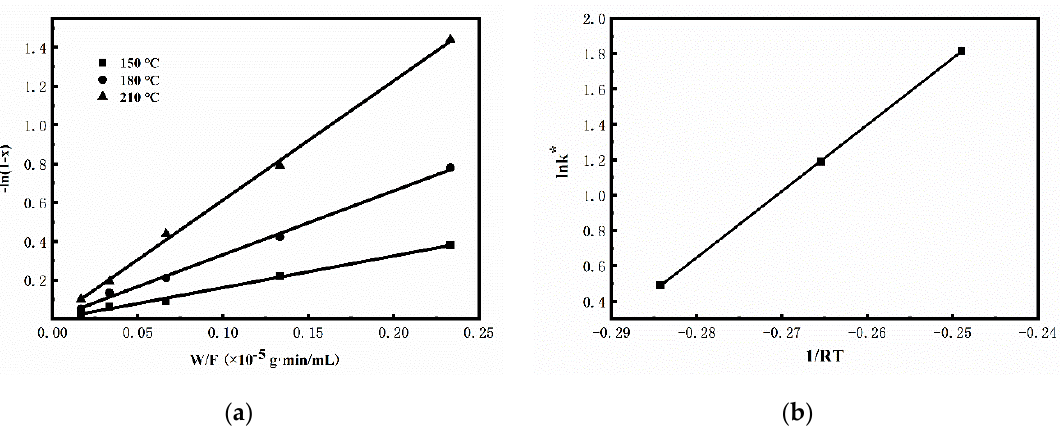
Figure 3. ( a ) First ‐ order reaction of NO result from which to determine the apparent reaction con ‐ stant, and ( b ) Arrhenius plot from which to determine the apparent activation energy.